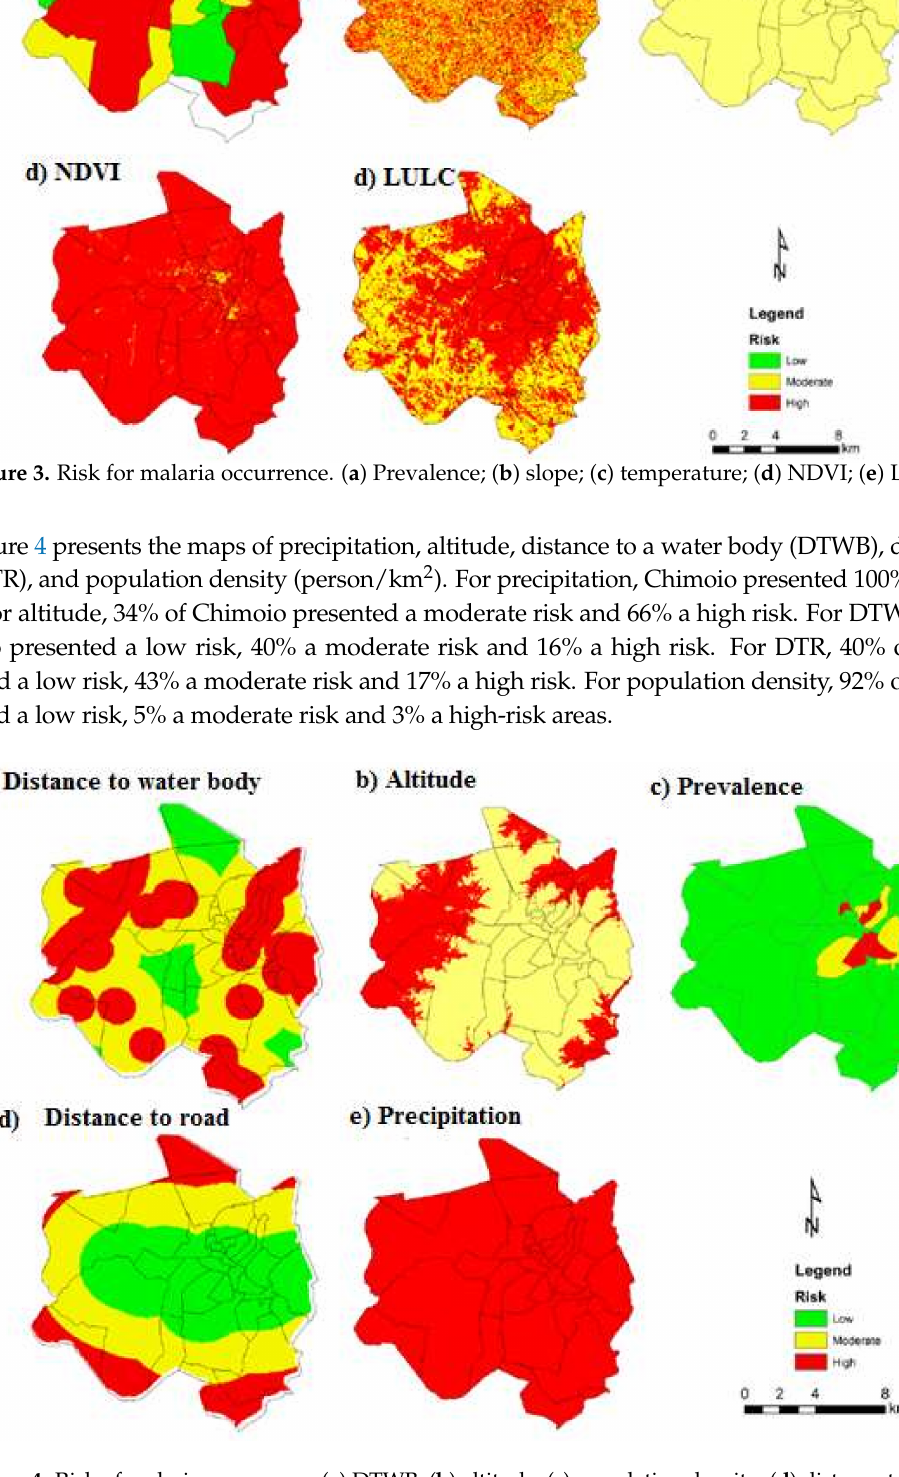
Figure 4. Risk of malaria occurrence. ( a ) DTWB; ( b ) altitude; ( c ) population density; ( d ) distance to road; ( e )